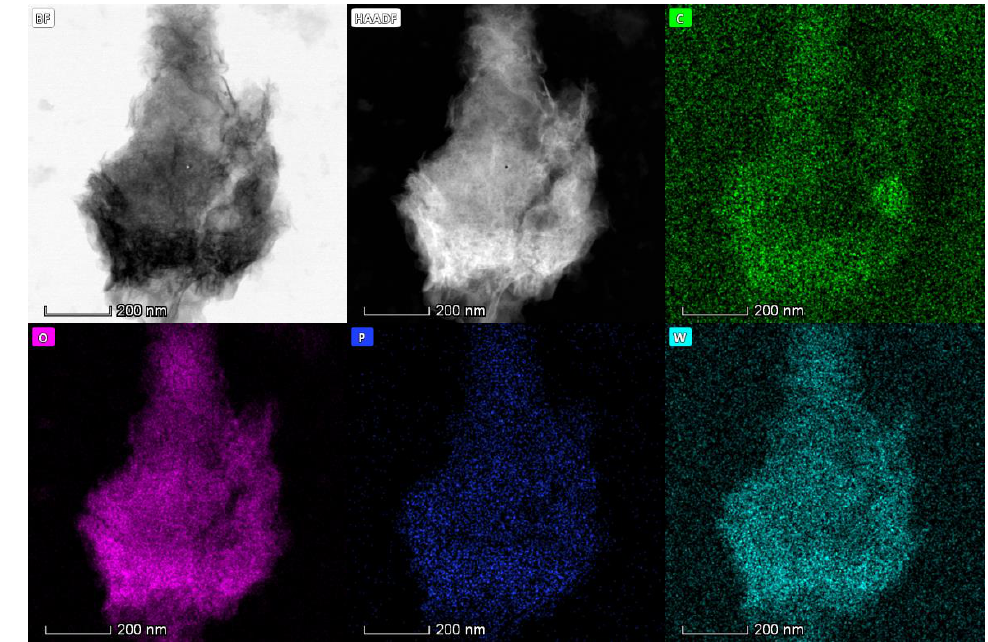
Figure 5. EDS elemental mapping images of 5%HPW/ SF−HPC .